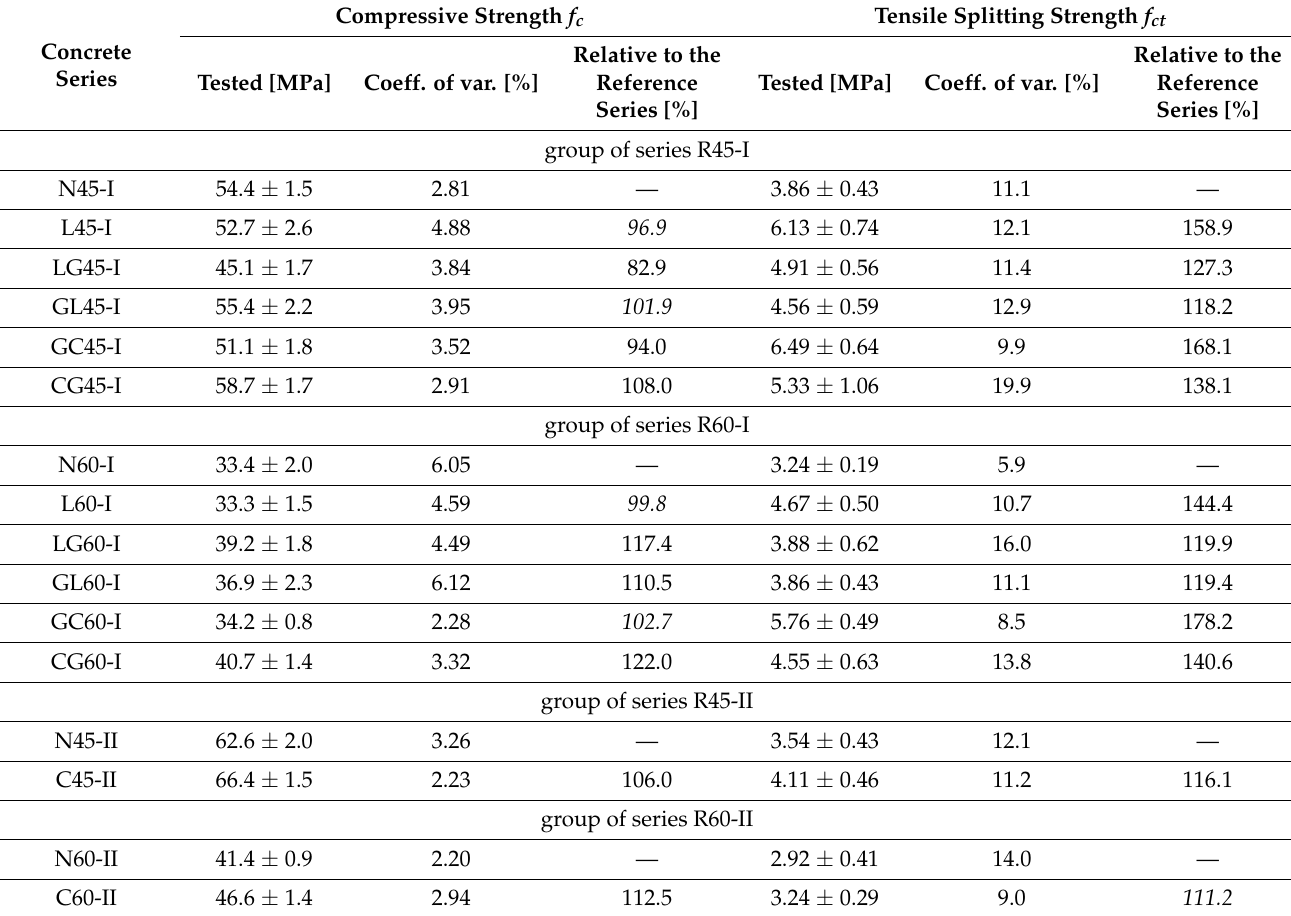
Table 4. Results of the strength